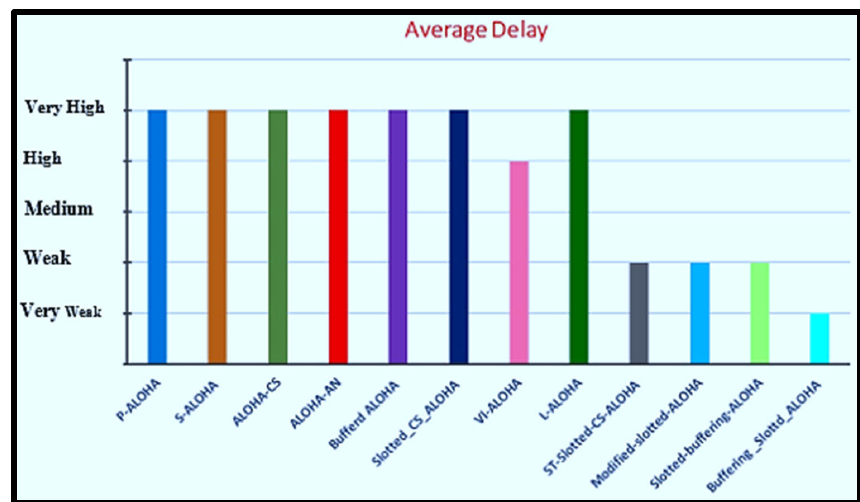
Figure 8. Comparison of average delay between different ALOHA protocols.